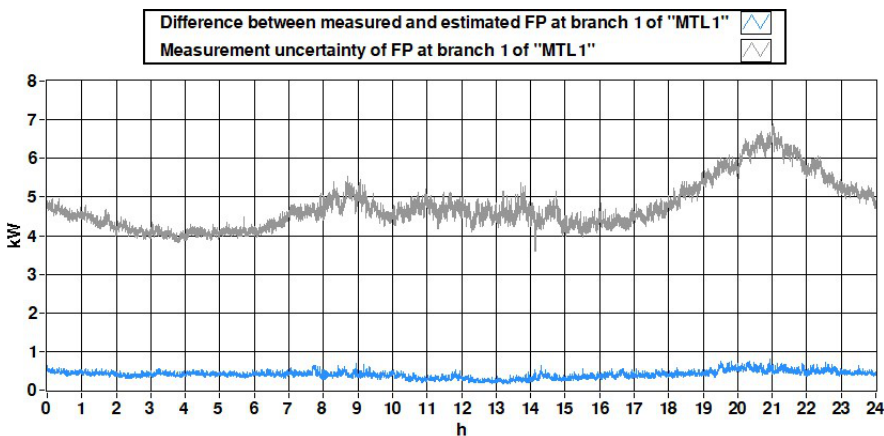
Figure 9. Difference between the measured and the calculated active power flow of branch 1 of the “MTL1” line and the uncertainty in its measurement (31 May 2018).